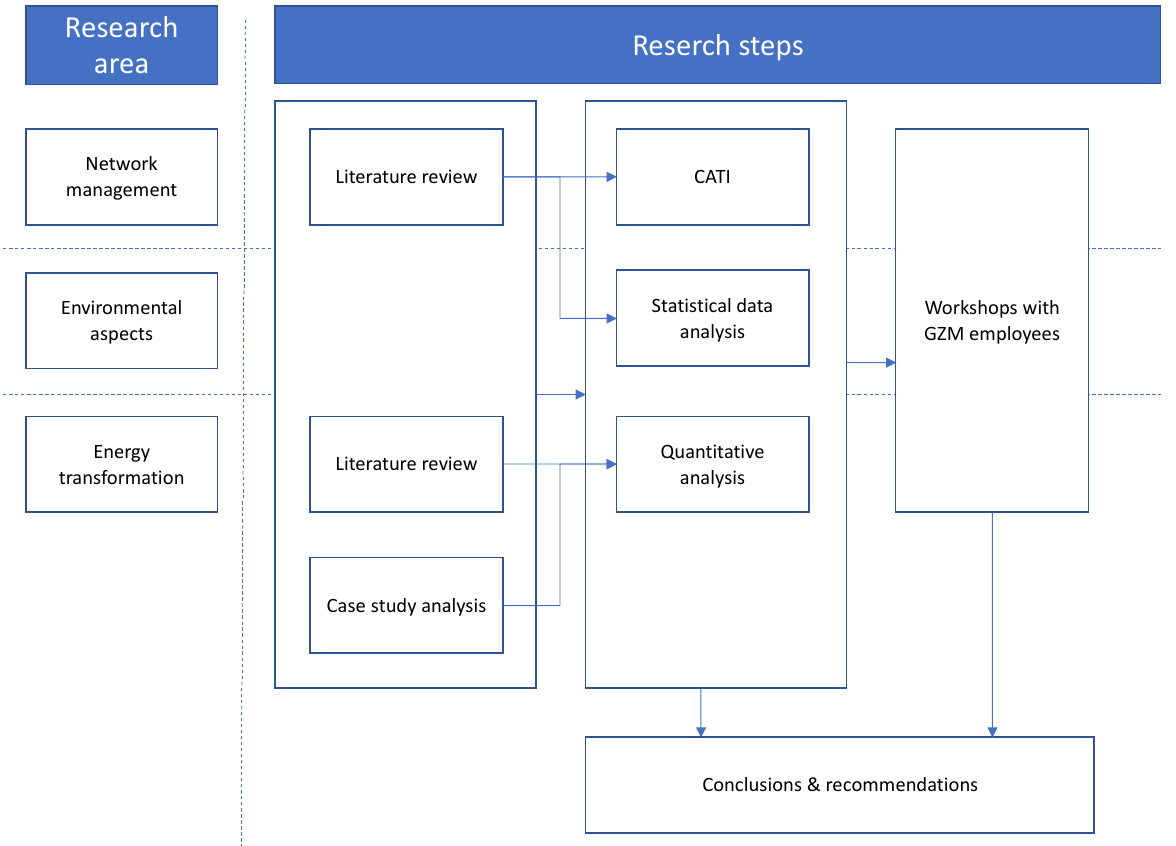
Figure 1. Research plan. Source: own elaboration.